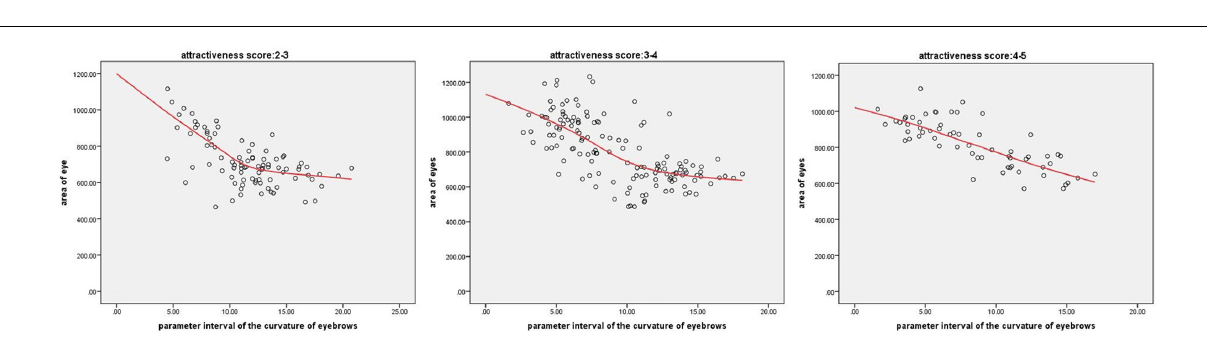
FIGURE 12 | The three figures are the scatter diagrams of the eye area and curvature of eyebrow when the attractiveness scores of face images are within the range of 2–3, 3–4, and 4–5, respectively.